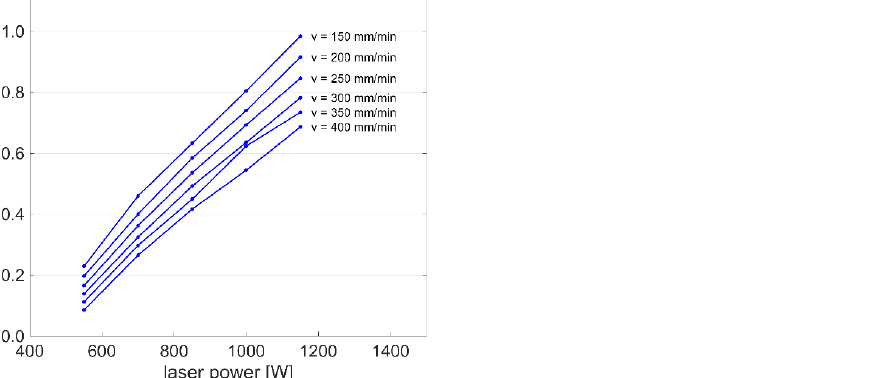
Figure 9. Remelting depth as a function of laser power and scanning speed with constant subtrate temperature of 0 °C, obtained by the heat conduction model. temperature of 0 ◦ C, obtained by the heat conduction model.